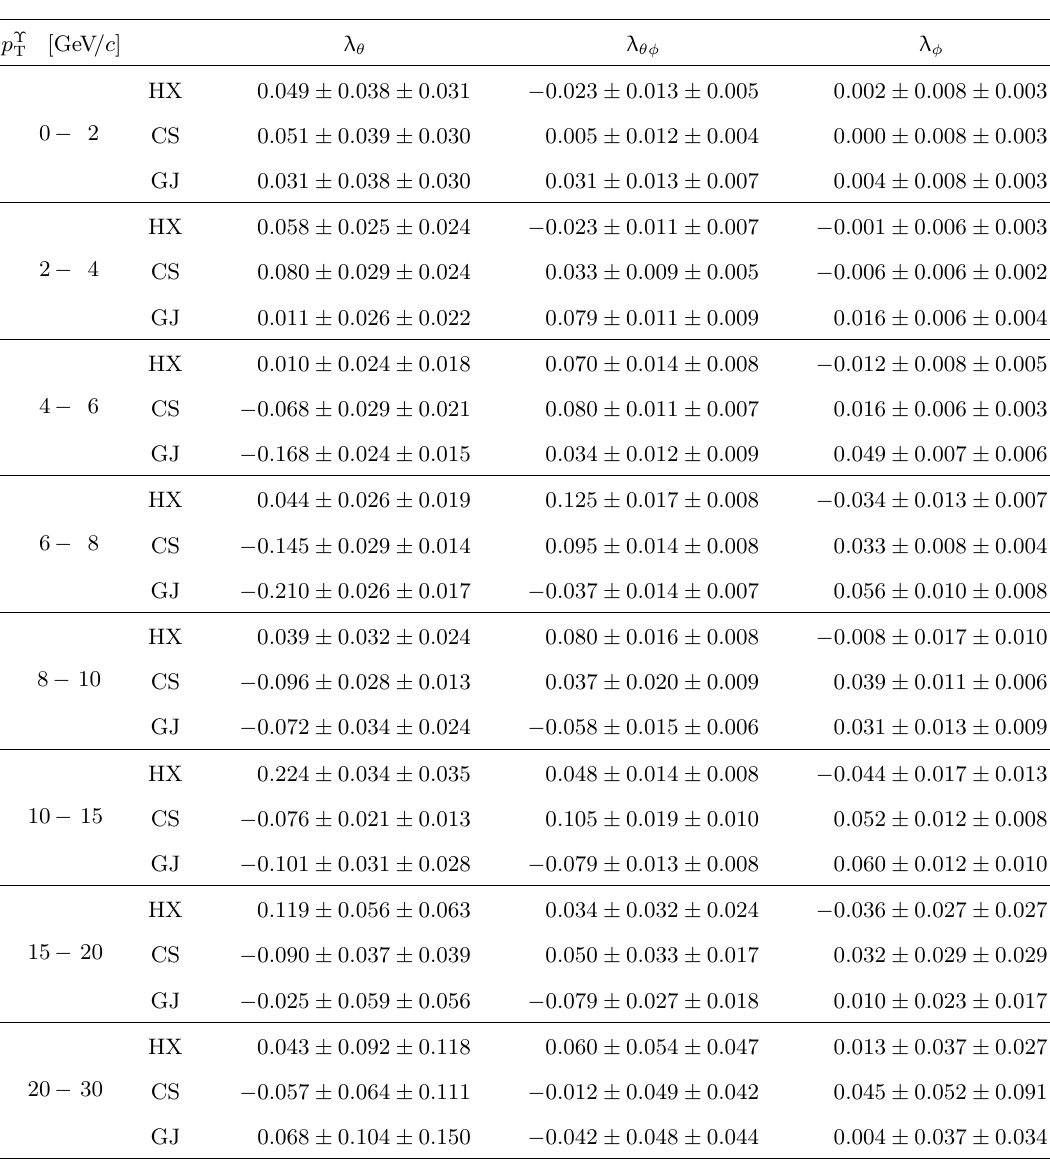
Table 18 . Values of (cid:21) (cid:18) , (cid:21) (cid:18)(cid:30) and (cid:21) (cid:30) measured in the HX, CS and GJ frames for the (cid:7)(2S) produced p at s = 8 TeV in the rapidity range 2 : 2 < y (cid:7) < 4 : 5. The (cid:12)rst uncertainty is statistical and the second